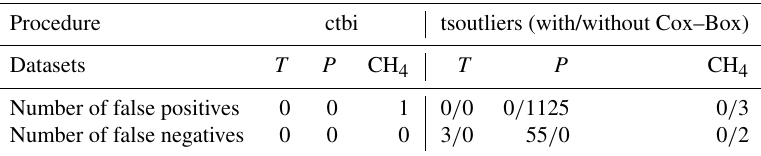
Figure 6. Aggregation of the temperature (a) , precipitation (b) , and methane (c) in two consecutive levels: 1 (thin lines) and 2 (bold lines). Only the first level of aggregated precipitation is shown for clarity. Black and red colors are associated with the raw and contaminated datasets, respectively. The mean cycles of the second level of aggregation are shown in the second column, with their SCI displayed (the raw and contaminated versions share similar values). Table 1. Number of false positives (real data points flagged as outliers, type I error) and false negatives (outliers that have not been flagged, type II error) for the contaminated temperature ( n = 8952), precipitation ( n = 10949), and methane ( n = 2103) datasets shown in Fig. 5, with the ctbi procedure and the tsoutliers function (with/without the Cox–Box